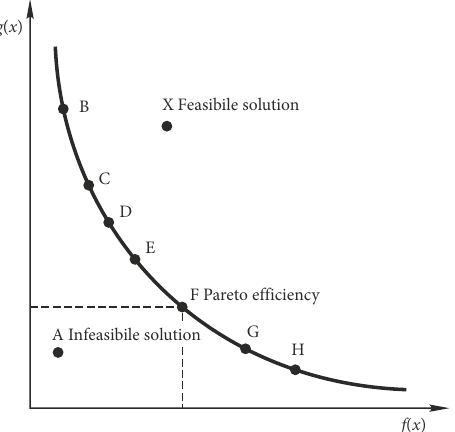
Figure 2. Pareto set of solutions on Pareto